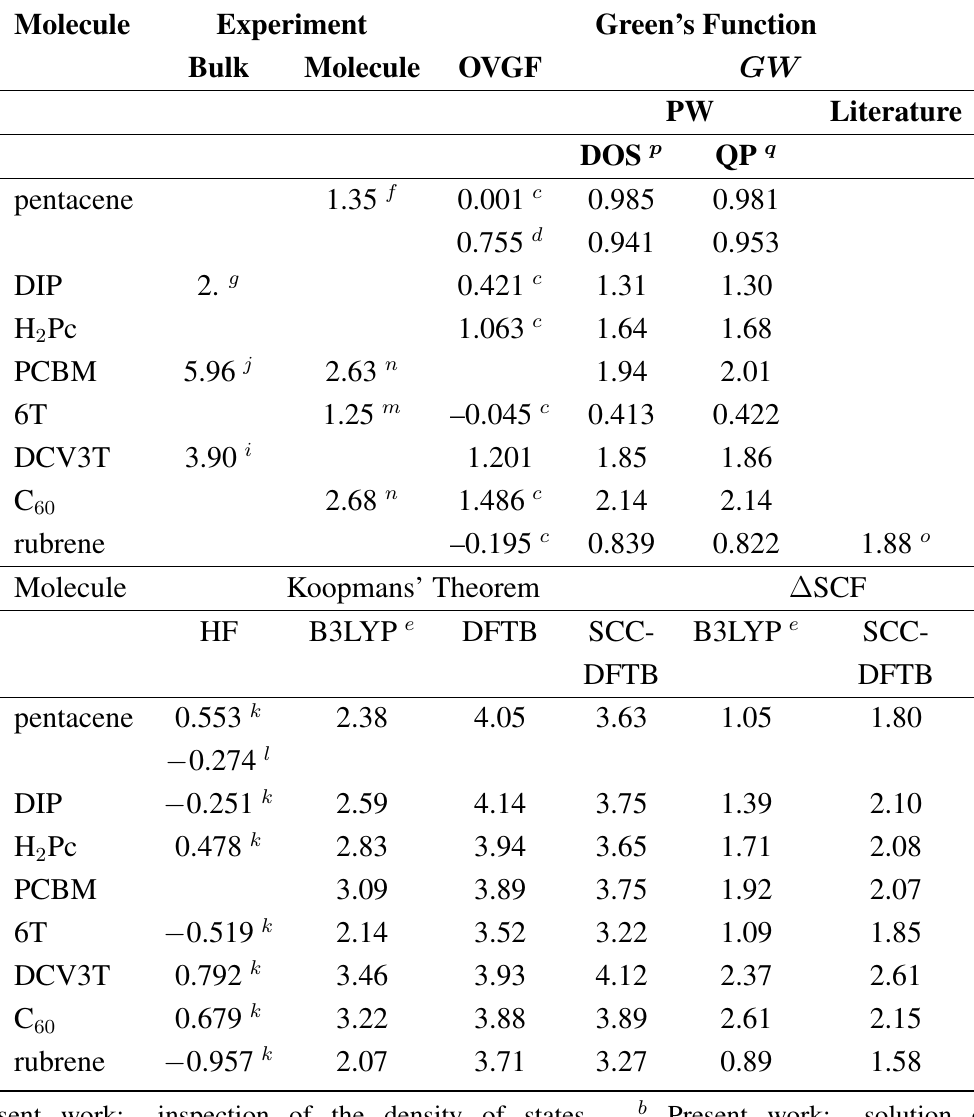
Table 6. Comparison values of the first electron affinity for the medium-sized molecules from the experiment and from quantum chemistry